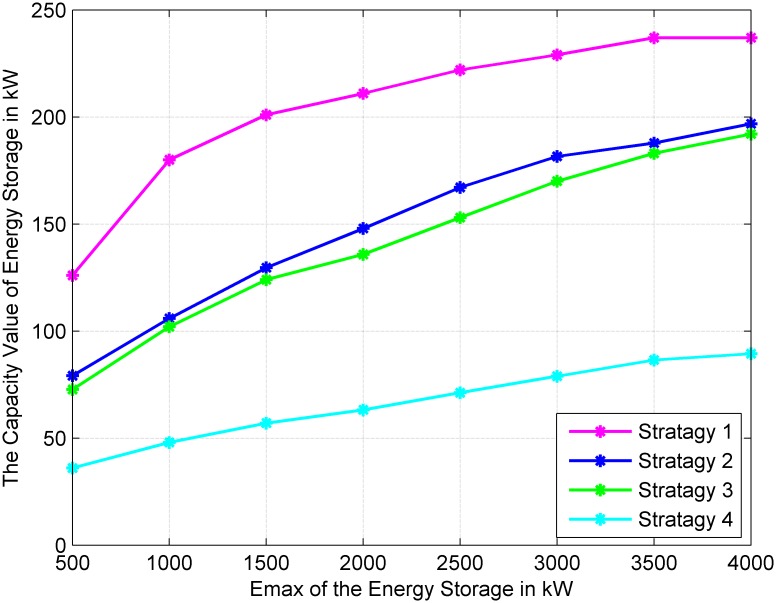
Variations of the capacity value of energy storage for different Emax of energy storage.